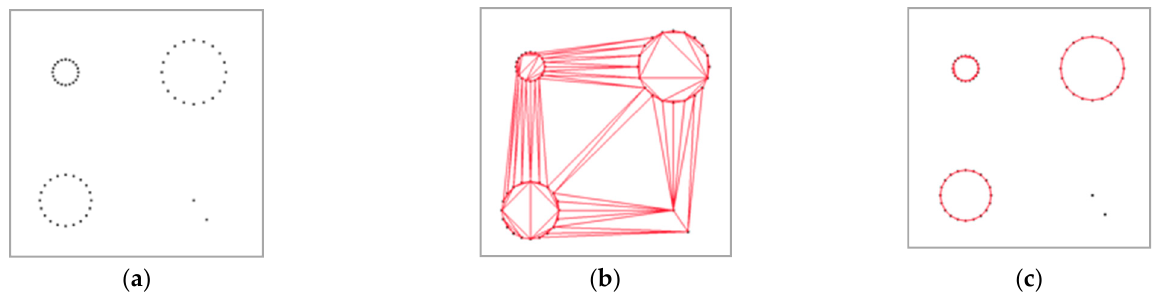
Figure 10. Segmentation of cross-sectional points. ( a ) Section points; ( b ) Delaunay triangulation; ( c ) connected components as stem section candidates.